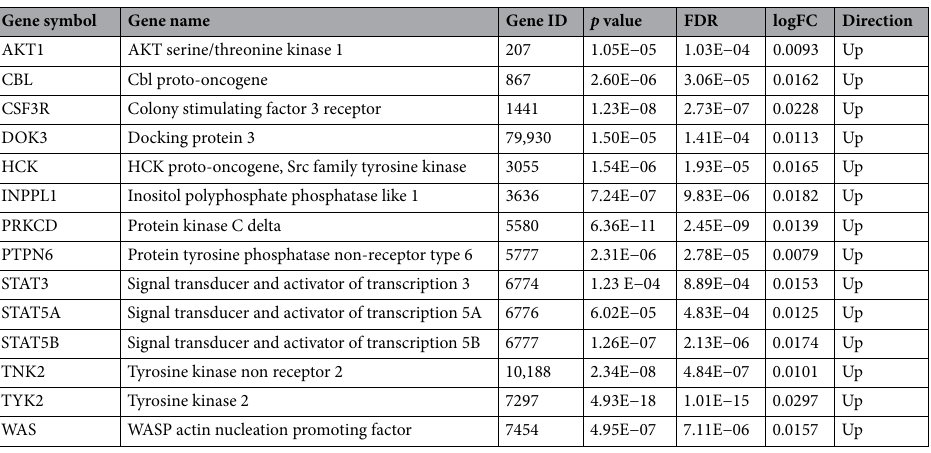
Table 3. AD gene signature. AD, Alzheimer’s disease; CTL, control; FC, fold-change AD/CTL; FDR, False Discovery